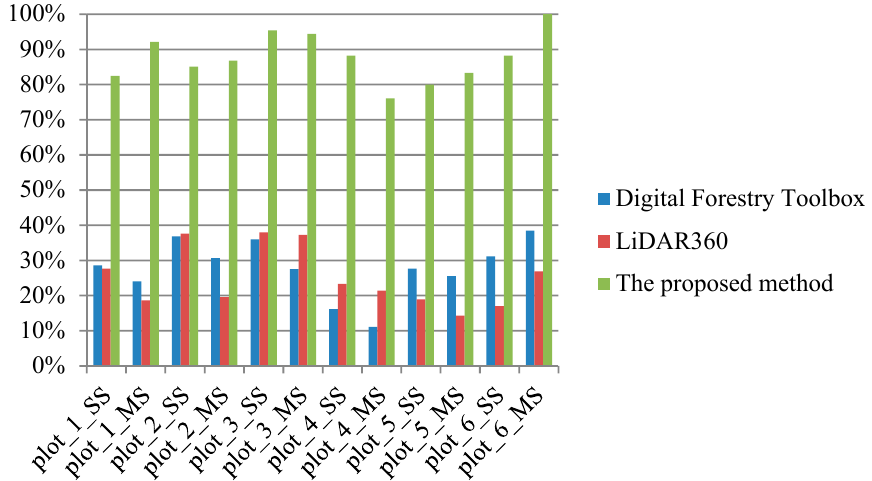
Figure 16. Comparison of correctness of the three methods towards the six plots.